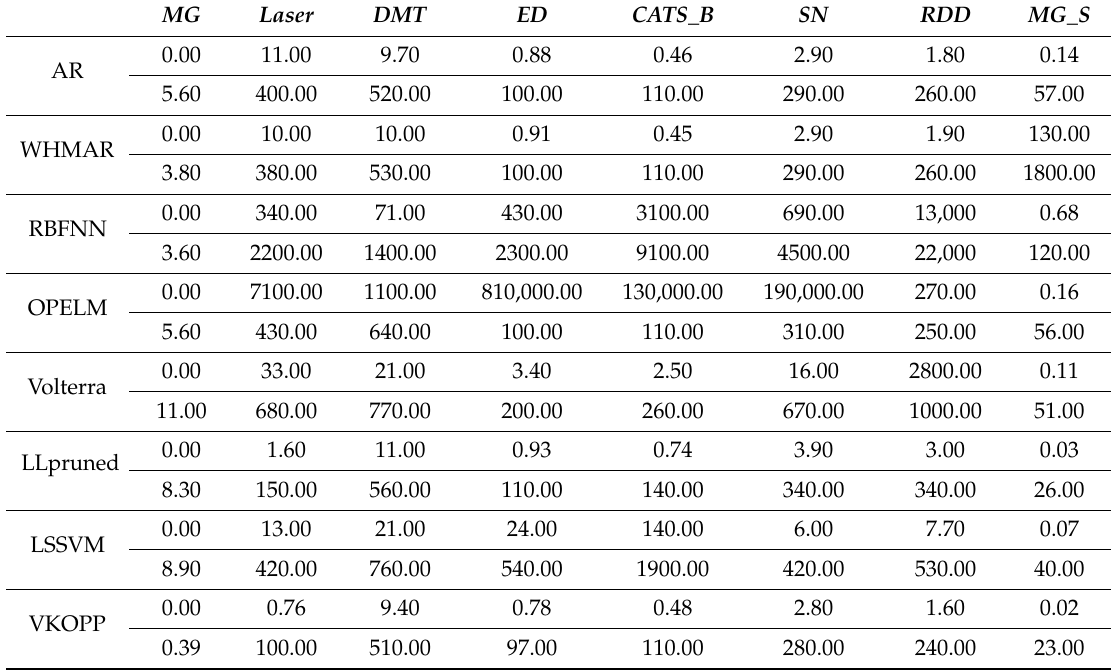
Table 4. One-step-ahead prediction: MSE in the top line (NRMSE in the bottom line) for all eight methodologies for eight datasets. ( × 10 − 3 ).